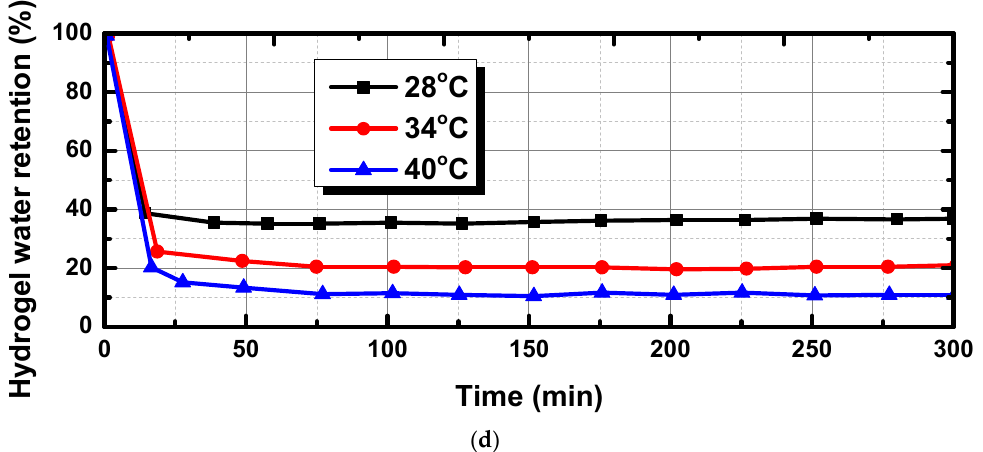
Figure 7. Weight of the hydrogel and residence time as a function of flow rate, and hydrogel water retention over time. ( a ) Secondary axis, showing the increment in pressure drop as a function of flow rate, ( b ) the corresponding mass flow rate is given in the secondary axis, ( c ) hydrogel water retention as a function of time for different fluid temperatures, at a constant flow rate of 10 mL/min, and ( d ) hydrogel water retention as a function of time for di ff erent fl uid temperatures, at a constant fl ow rate of 50 mL/min.